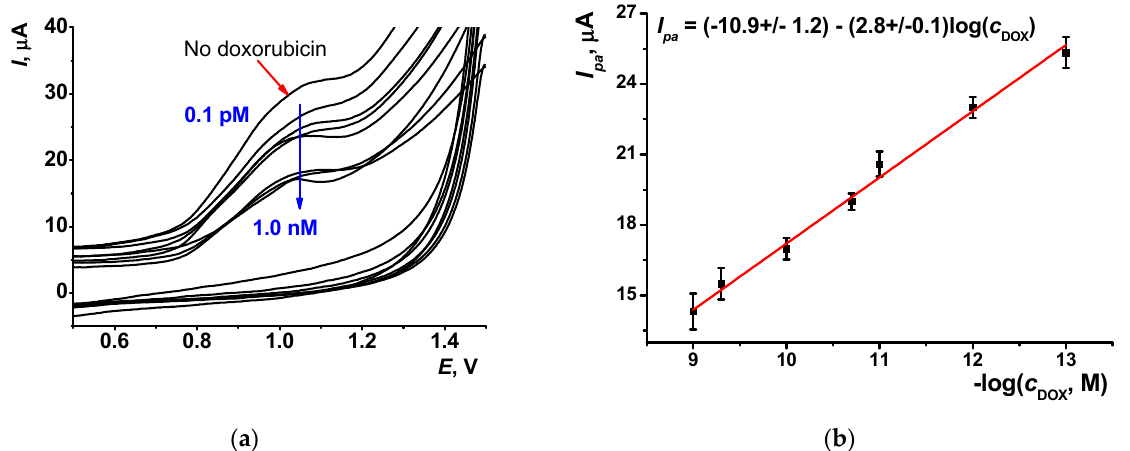
Figure 8. ( a ) Cyclic voltammograms recorded on the GCE covered with CB/AY (1:1 mixture, DMF, DNA, 2 µL/mL) after 20 min incubation in doxorubicin solution (0, 0.1, 1.0 pM, 0.01, 0.1, 1.0 and 5.0 nM). ( b ) Calibration plot of doxorubicin (DOX), measurements in 0.025 M phosphate buffer, pH = 3.0. Average for three individual electrodes.